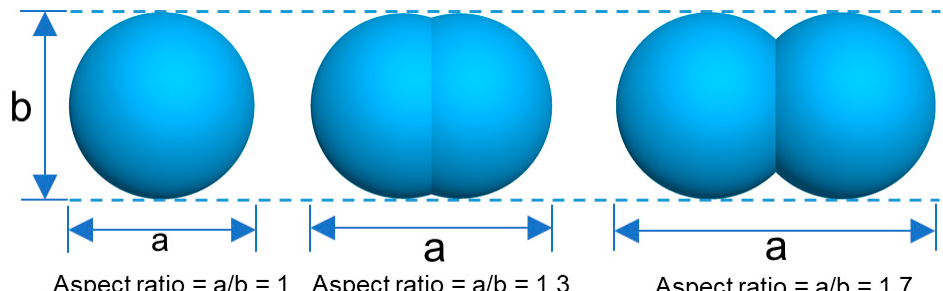
Figure 3. Three kind of particle shapes in the simulation.